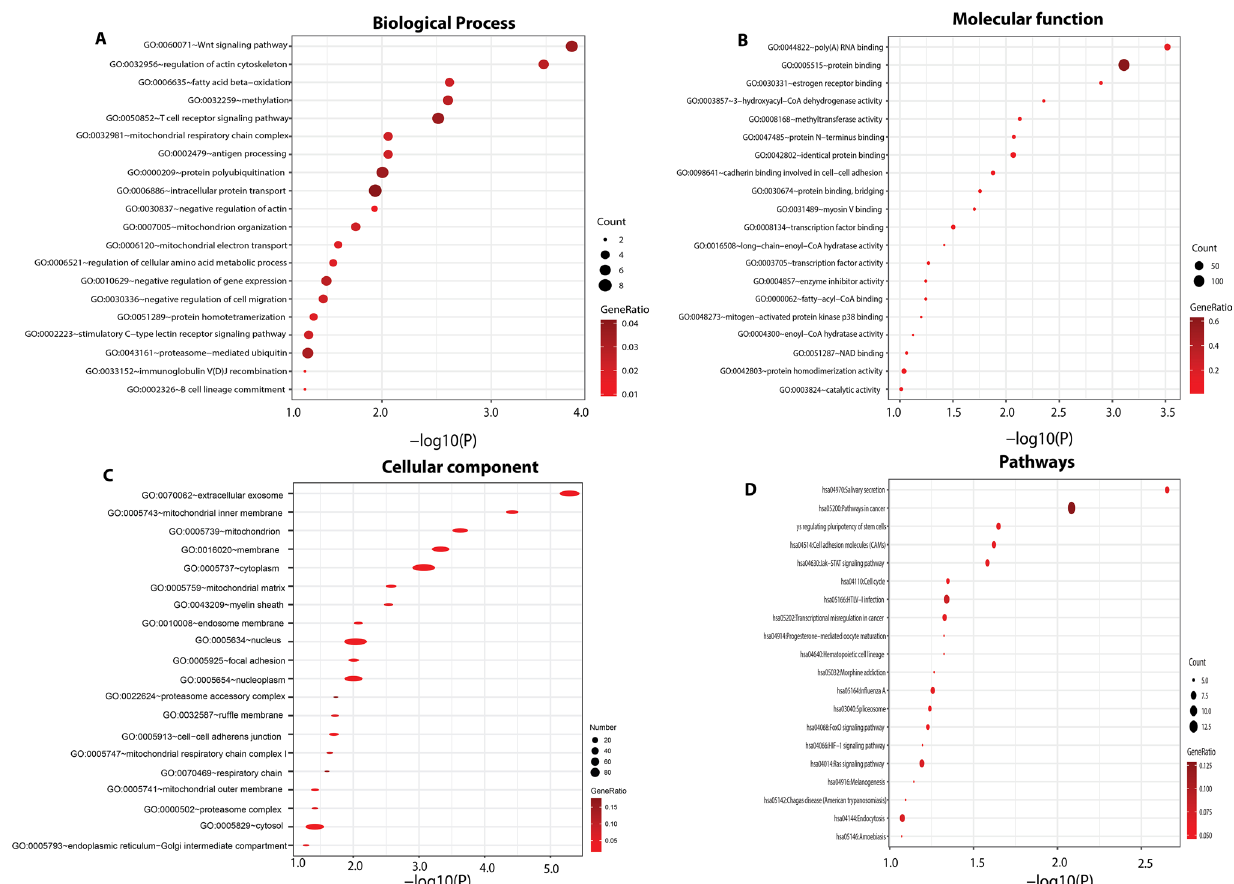
Fig. 4 Functional and pathway enrichment analyses of down-regulated DEGs in leukemia (chronic lymphocytic and myelogenous). A Biological process enrichment analysis of up-regulated DEGs. B Molecular function. C Cellular component. D KEGG pathway enrichment